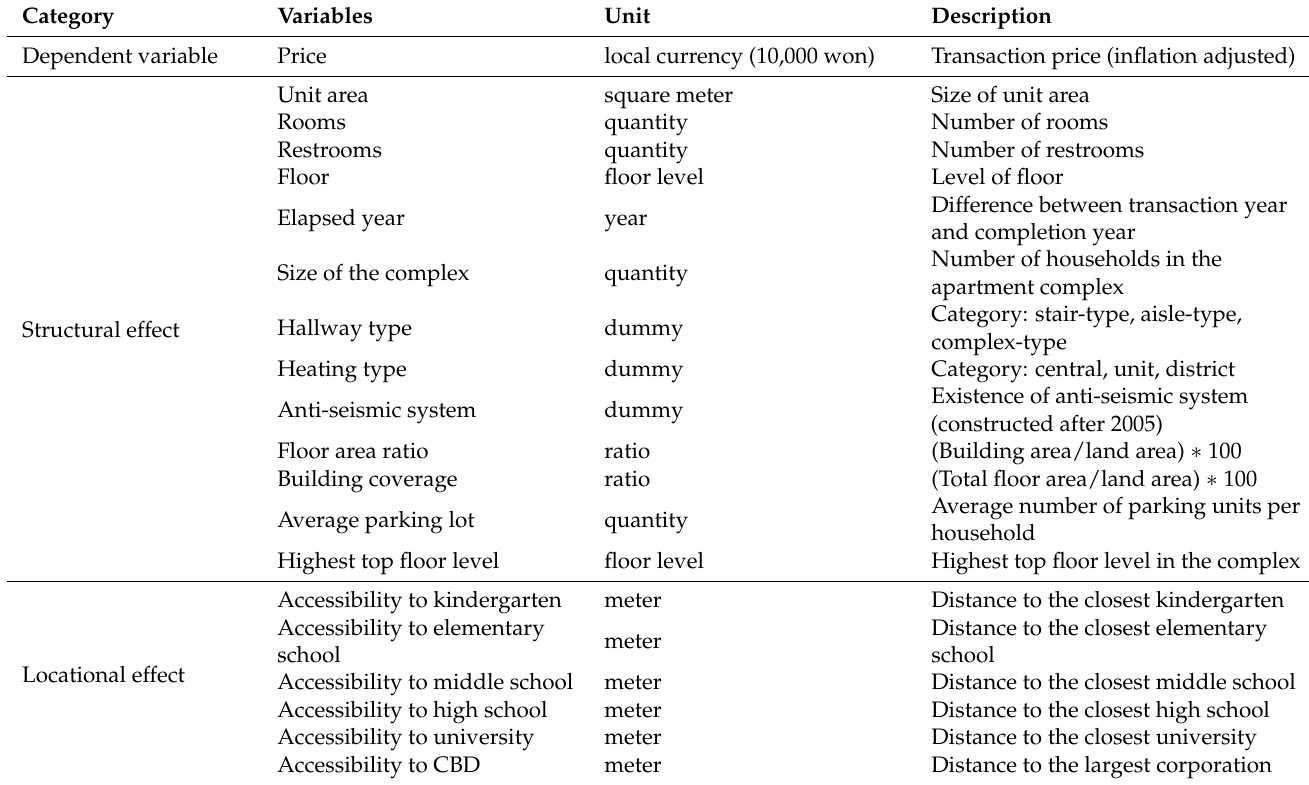
Table 1. Variable